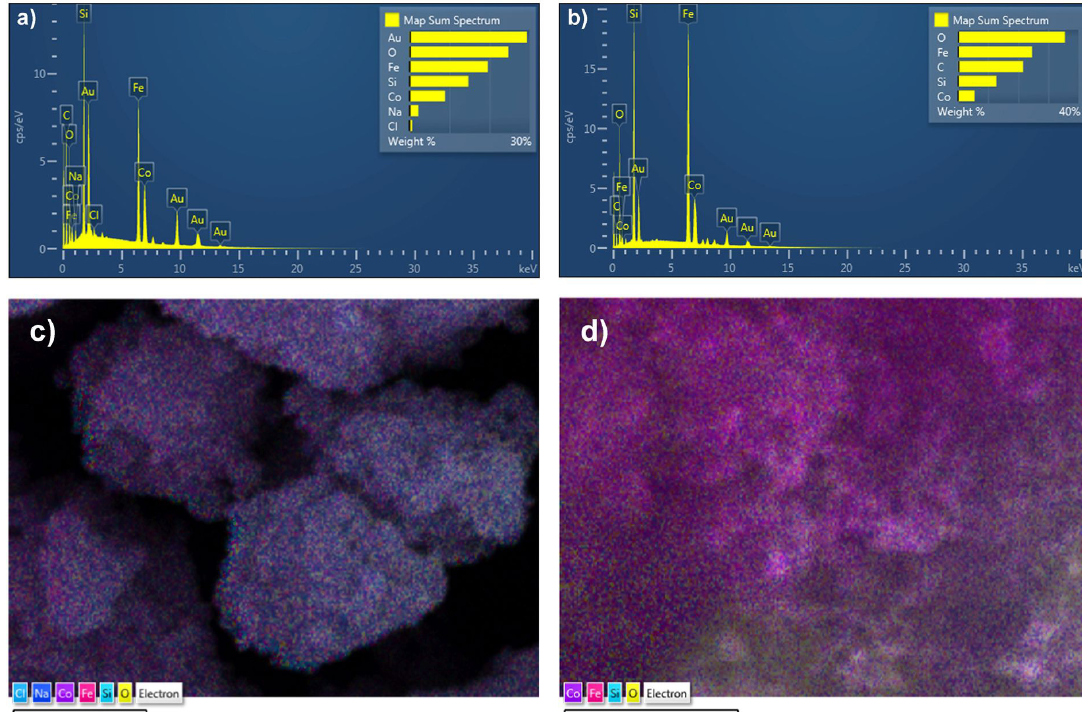
Figure 8. EDS spectrum and chemical mapping of the sample CF2-15 (a, c) and CF4-11 (b,